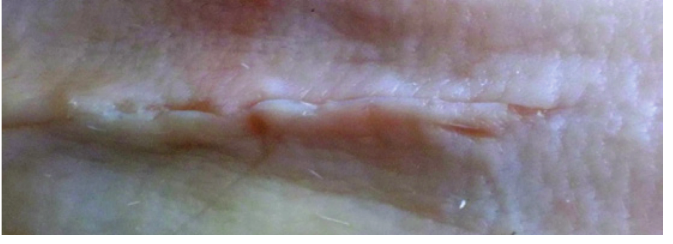
FIGURE 4 – Totally hidden intradermal